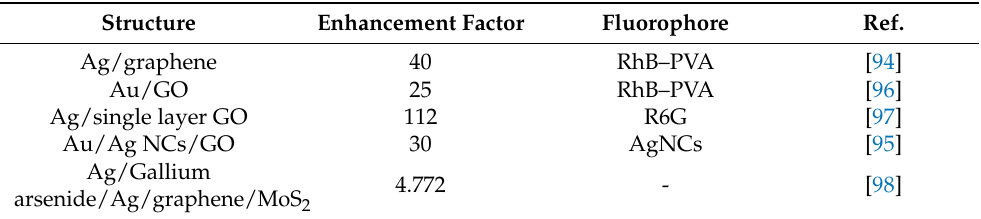
Table 6. A summary of selected papers regarding graphene-based plasmon coupled emission